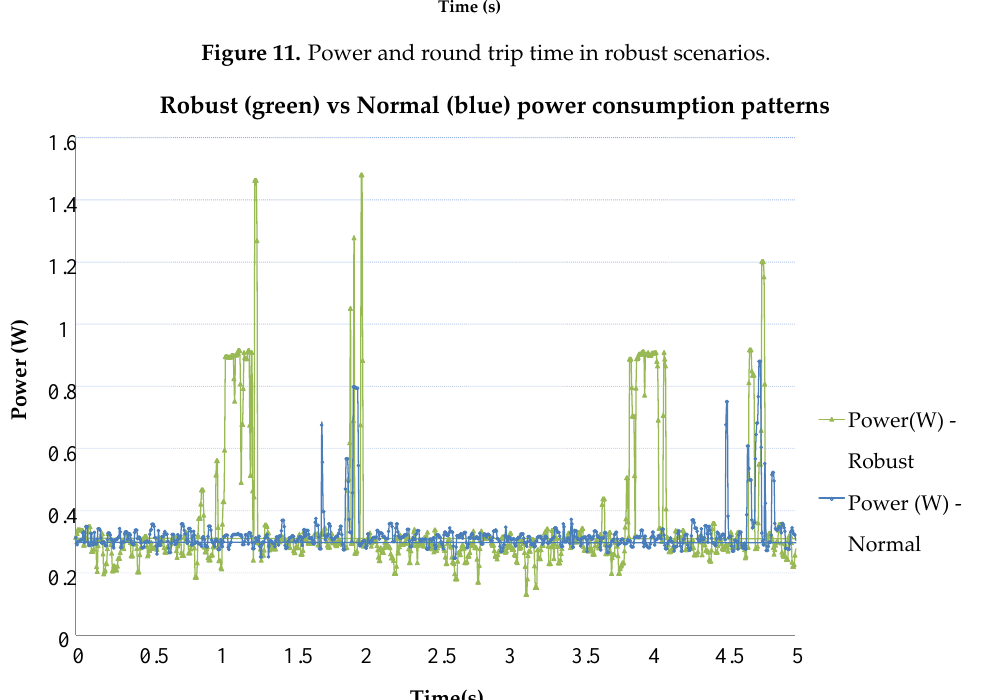
Figure 12. Robust vs. Normal scenario power consumption